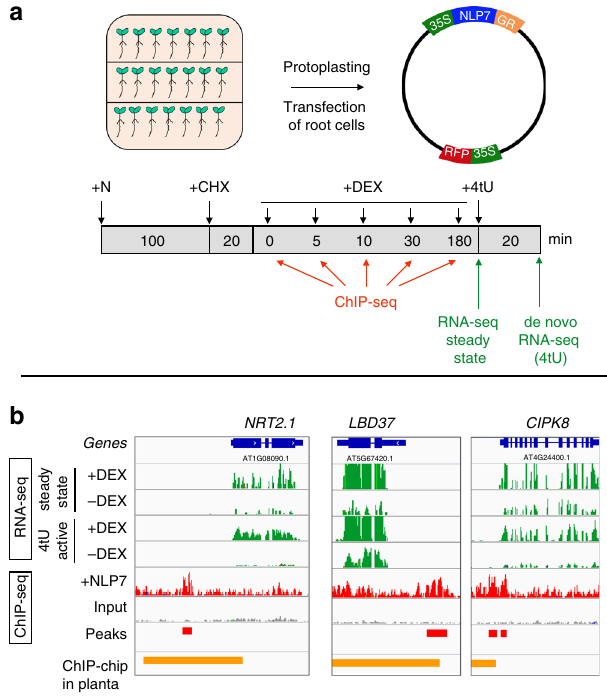
Fig. 1 TARGET TF-perturbation assay captures direct targets of NLP7 based on TF regulation or TF binding in isolated root cells. a Schematic of the cell-based TARGET TF-perturbation system and experimental design 22 (see “ Methods ” ). Root cells isolated from an nlp7 mutant 11,23 transfected with a 35S::NLP7-GR construct were allowed to express the TF – GR fusion protein and sequentially treated with (i) the nitrogen (N) signal transduced by the TF, (ii) cycloheximide (CHX) to block translation, allowing mRNA synthesis of only direct NLP7 targets, (iii) dexamethasone (DEX) to induce NLP7-GR nuclear import. Samples for NLP7 binding to targets as assayed by ChIP using anti-GR antibodies were collected after 0, 5, 10, 30, and 180min of DEX-induced TF nuclear import. Genes whose expression is affected NLP7 nuclear import were assayed by RNA-seq (steady-state mRNA) or by af fi nity capture of de novo mRNA using 4tU 16 . b Representative examples of direct targets transcriptionally activated by NLP7. The expression of NRT2.1 , LBD37 , and CIPK8 is induced by + DEX as compared with − DEX treatment in both steady state and 4tU-enriched RNA-seq experiments (green bars). NLP7 binding was captured by ChIP-seq, and NLP7 peaks were identi fi ed by MACS2 using an input sample as a control (red bars) (see “ Methods ” ). NLP7 peaks identi fi ed in whole roots by ChIP-chip (orange bars) 11